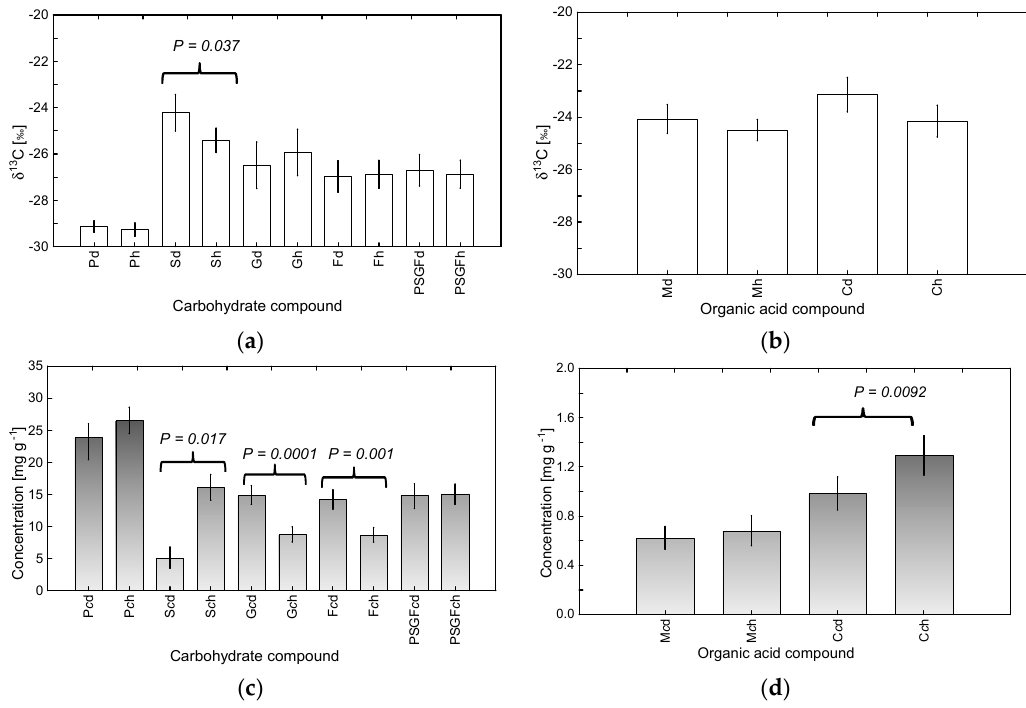
Figure 4. Averaged seasonal δ 13 C values ( a ) of carbohydrates: pinitol (P), sucrose (S), glucose (G), and fructose (F); and ( b ) organic acids: malate (M) and citrate (C); and their concentrations ( c , d ), and average of total carbohydrates (PSGF) in needles of declining (d) and healthy (h) mountain pine trees. Error bars are based on ± 1 SE (standard error). Statistically significant differences in δ 13 C values and concentrations of carbohydrates and organic acids in needles of healthy and declining mountain pine trees are marked on the top as P -values.